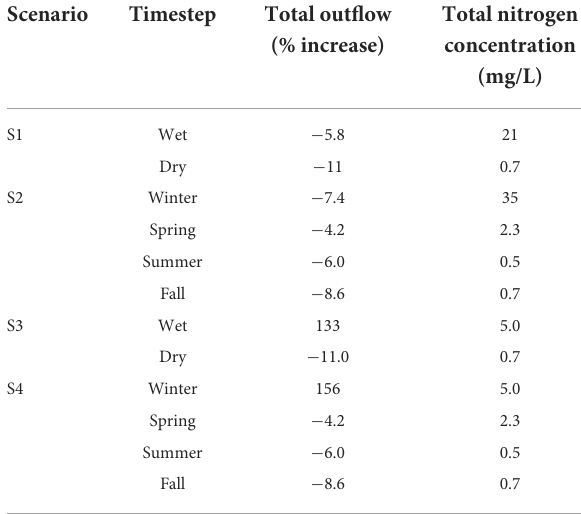
TABLE 5 Percent increase in total watershed outflow and average total nitrogen (TN) concentration in